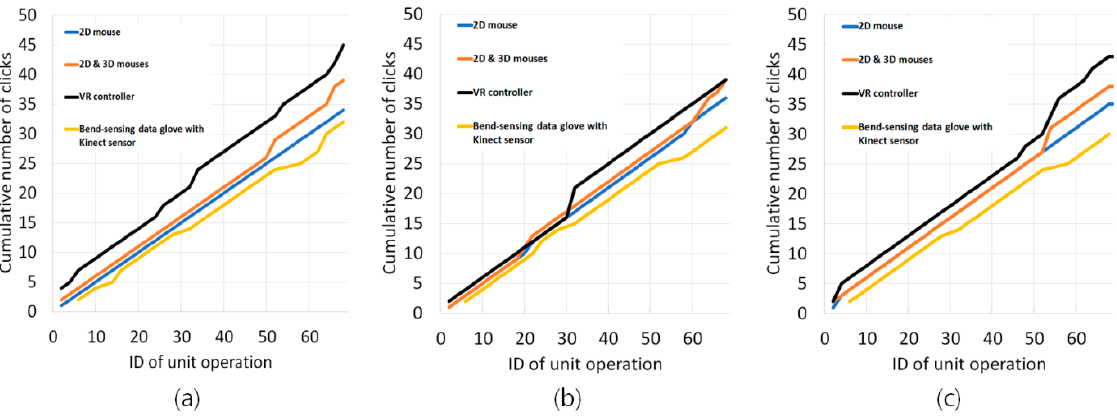
Figure 5. The cumulative number of clicks for controlling KmodStudio in a virtual reality (VR) environment using different user interface devices. Experimenter No. ( a ) 1, ( b ) 2, and ( c ) 3.